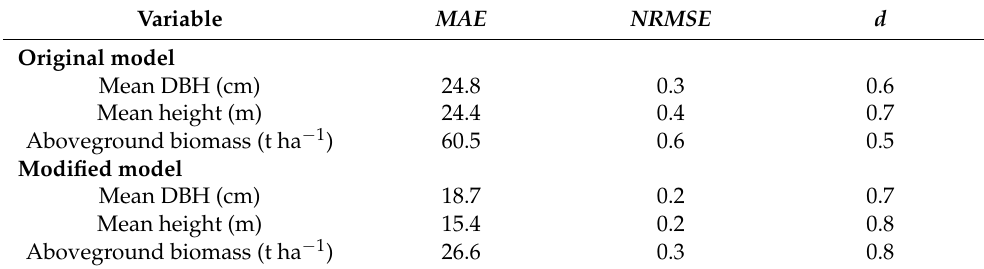
Table 3. Performance of the original and modified TRIPLEX-Management model.